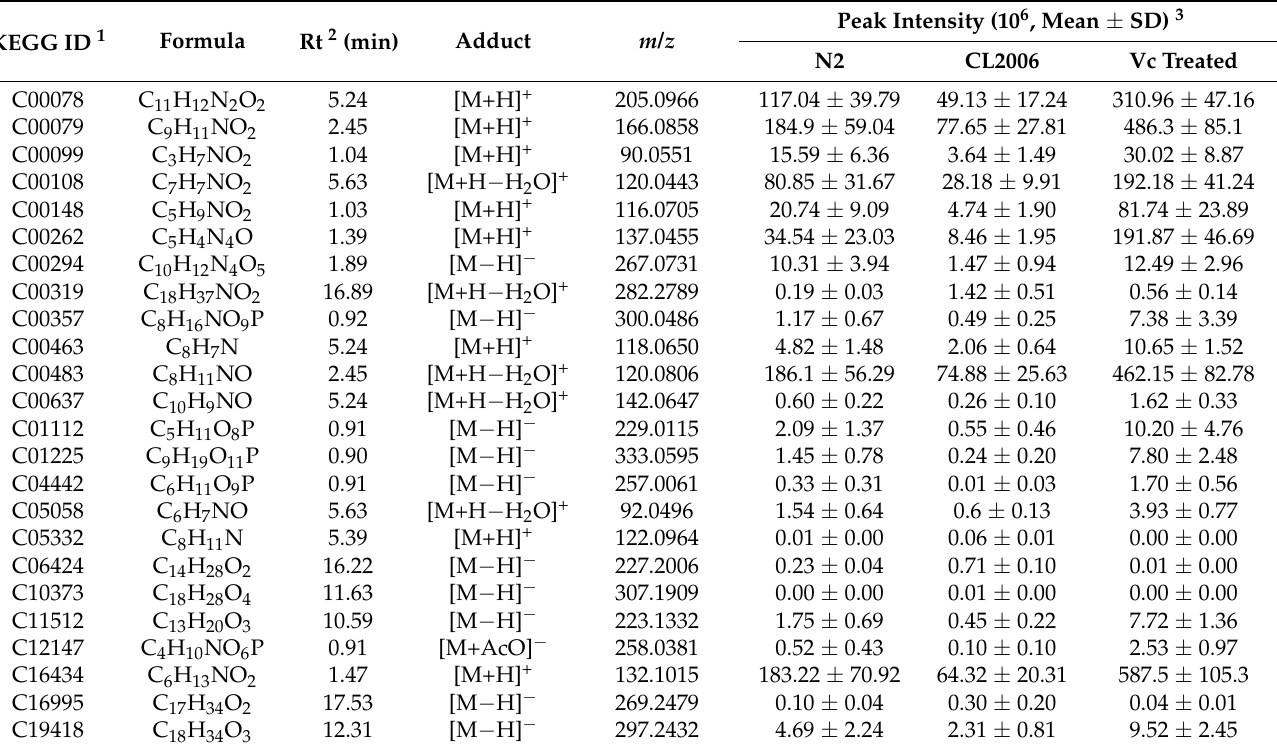
Table 1. Reversed metabolites among the groups N2, CL2006 and Vc